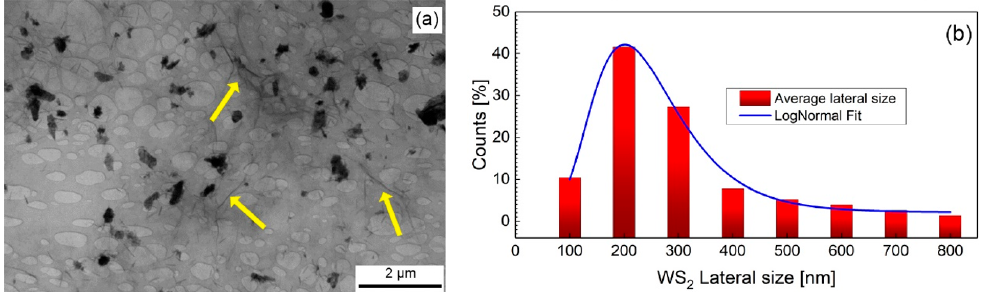
Figure 1. ( a ) Low-resolution TEM image of WS 2 -decorated GO deposited on a lacey grid. WS 2 flakes (darker regions) distributed over interconnected rGO flakes (light-grey background). The occurrence of grey lines (highlighted by yellow arrows) attest the formation of rGO folded edges; ( b ) Lateral size distribution of WS 2 flakes and corresponding Log Normal fit.